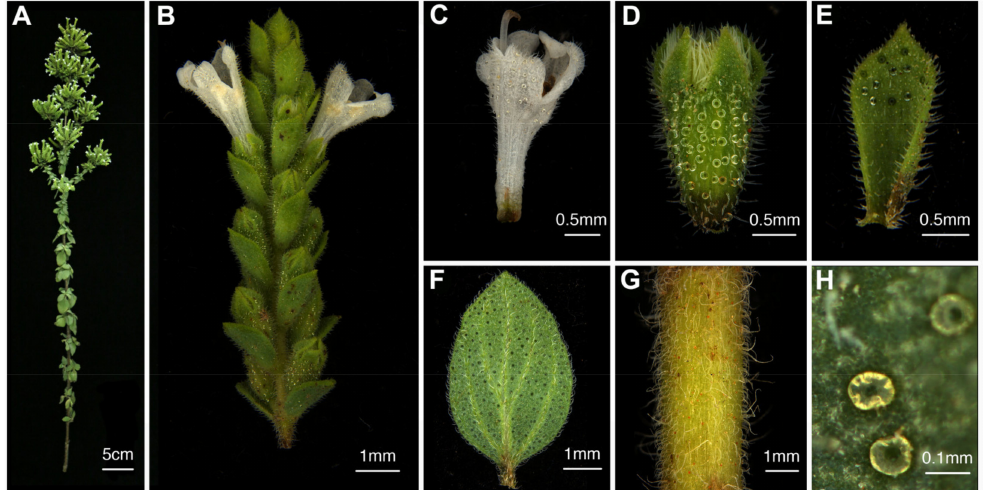
Figure 1. Photographs of Origanum vulgare ‘Hot and Spicy’ plants at the full bloom stage. The aerial part of O. vulgare ‘HS’ ( A ). The inflorescence of O. vulgare ‘HS’ ( B ). Different tissues of petals (PE; ( C )), sepals (SE; ( D )), bracts (BR; ( E )), leaves (LE; ( F )), and stems (ST; ( G )). Peltate glandular trichomes of O. vulgare ‘HS’ ( H ).